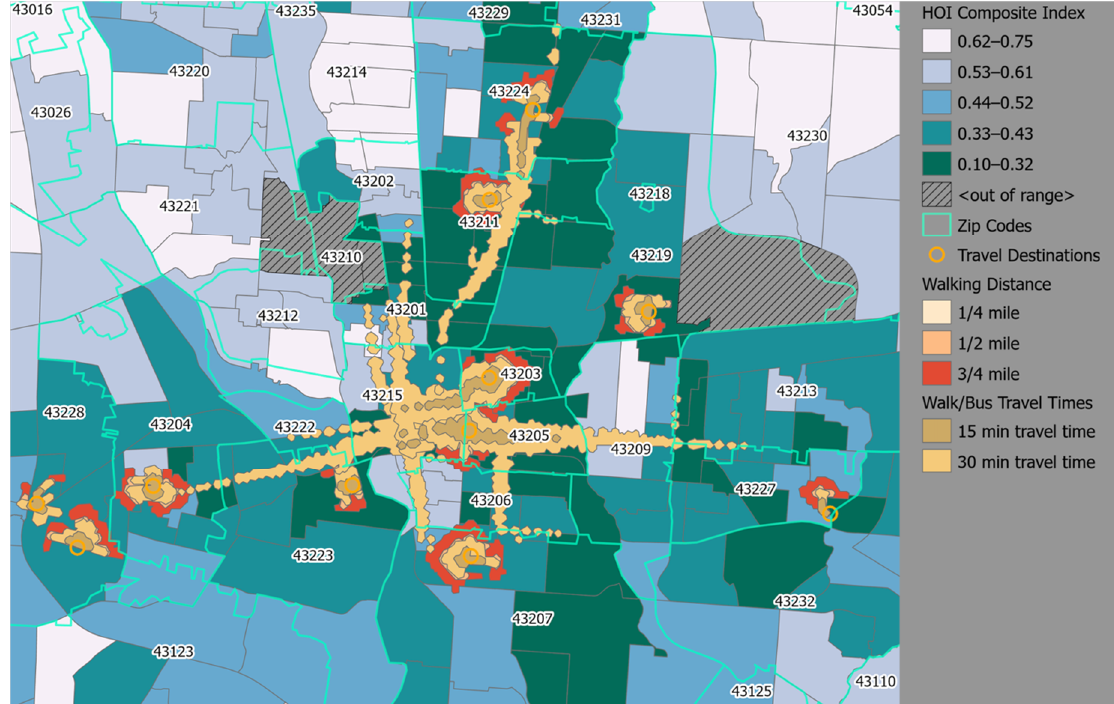
Figure 4. Health Opportunity Index (HOI) composite map of the vulnerable (dark green) census tracts in metropolitan, urban Columbus, Ohio. The census tracts are color coordinated based on what quintile their HOI composite score falls in. In this analysis, the lower HOI composite scores fall in Quintile 1, while the higher HOI scores fall in Quintile 5. [Reproduced and adapted with permission from the corresponding author of Ogojiaku et al., 2020 on 18 October 2022] [75].